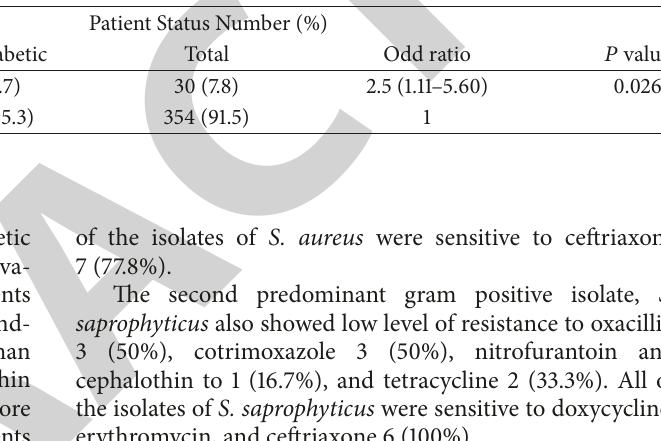
Table3:PrevalencebacterialurinarytractinfectionindiabeticandnondiabeticpatientsattendingDebreTaborHospital,NorthwestEthiopia,